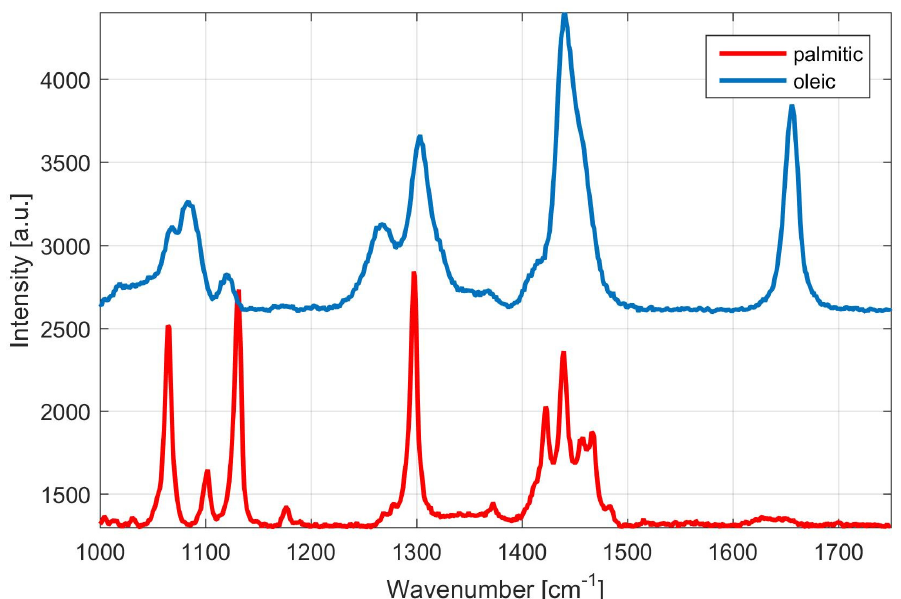
Figure 5. Typical Raman spectrum of palmitic (bottom trace) and oleic acid (upper trace). Spectra are vertically shifted for clarity. Graph illustrates differences between monounsaturated fatty acid (oleic) and saturated fatty acid (palmitic).